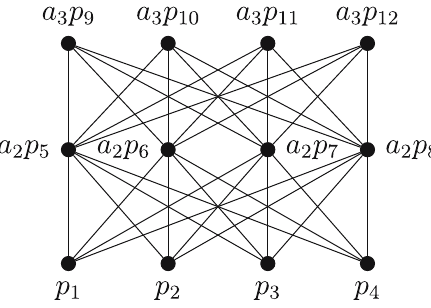
The subgraph of 3 is a complete 3 - partite graph in which each partition has four vertices that are independent ( Figure 4 ) .